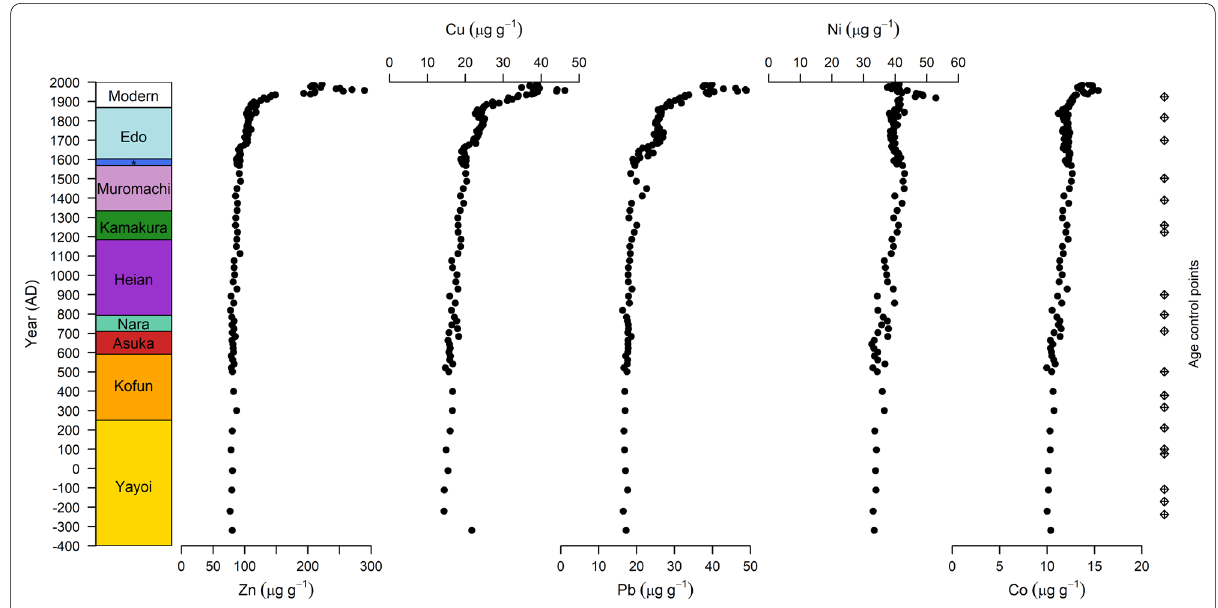
Fig. 4 Trace metal concentrations of the bulk sediment in the piston core during the last 2300 years. *Azuchi-Momoyama period